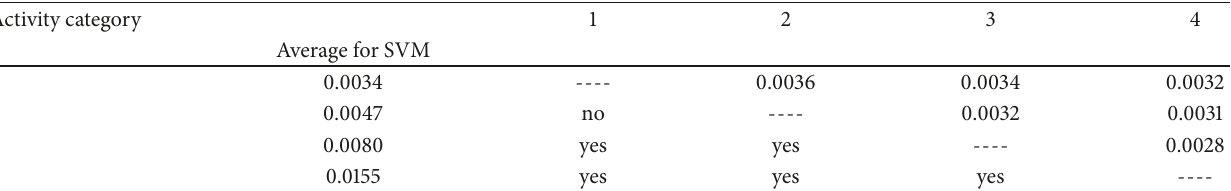
Table 3: ANOVA for SVM distributed according to clinically defined activity categories. The table shows the critical average differences between group pairs (right up) and the statistical significance evaluation ( 𝑝 < 0.05 ) left down.